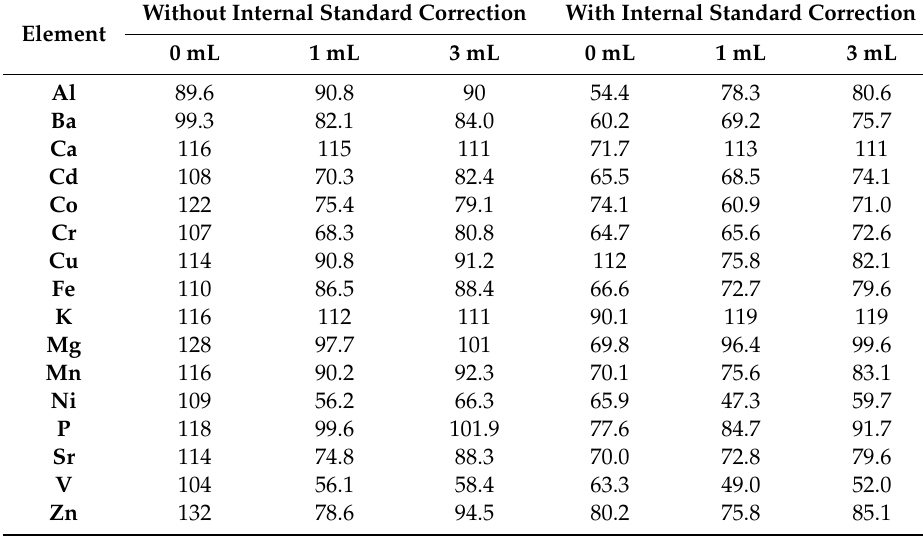
Table 3. Recoveries (%) obtained analyzing Standard Reference Material (SRM) 1573a with di ff erent